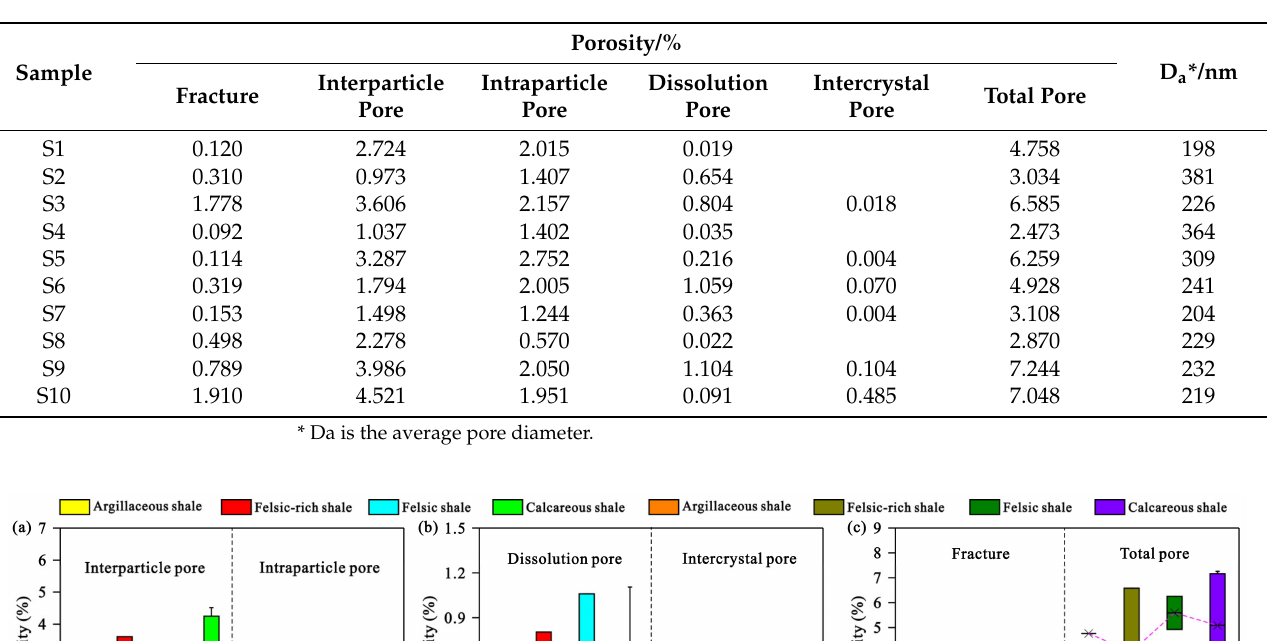
Table 3. Porosity and average diameters of different types of pores in the studied shales.